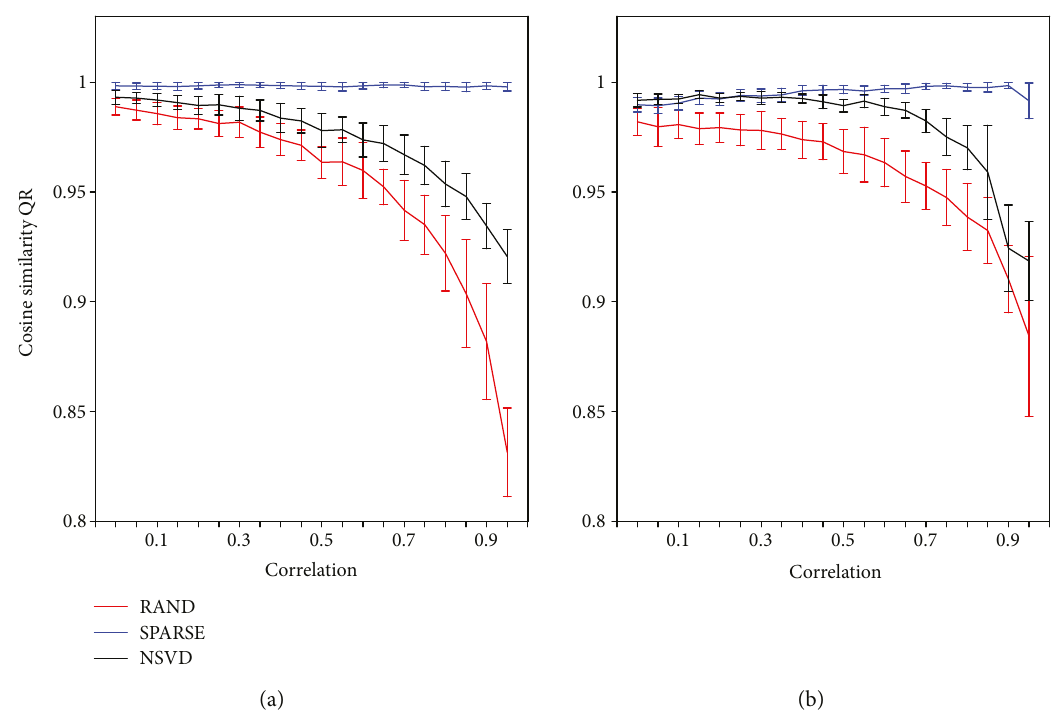
Figure 3: Performance of NNMF with three di ff erent initialization techniques. Average cosine similarity between the synergies extracted from an initialization technique and the original simulated synergies W . For each of the 20 correlation levels between the activation coe ffi cients C , the performance is reported as median ± median absolute deviation across 100 realizations. (a) Data generated with independent synergy vectors W I . (b) Data generated with dependent synergy vectors W D